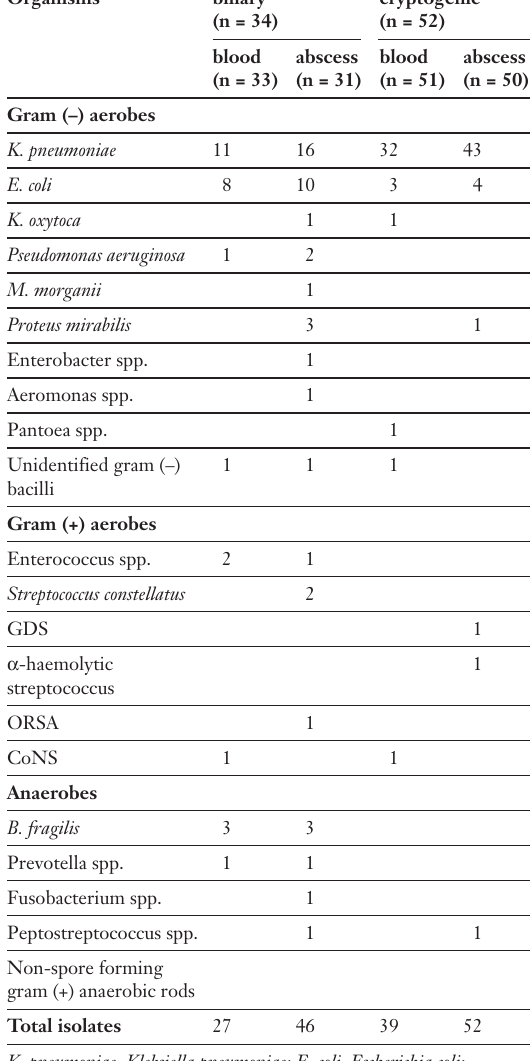
Microbiologic find- ings in the biliary and cryptogenic